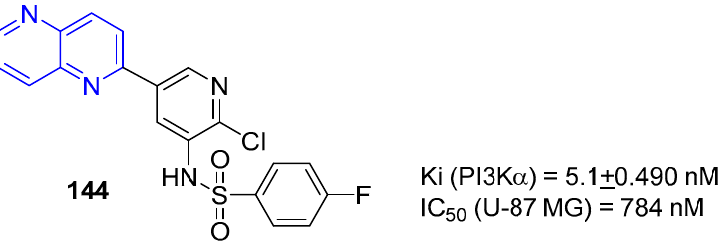
Figure 8. PI3K α inhibitory activity and cytotoxicity on U-87 MG cells.